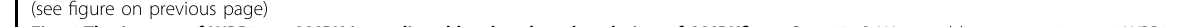
Fig. 6 The impact of WBP2 on AMPK is mediated by the phosphorylation of AMPK β 1 at Ser108. A Western blot assays using anti-WBP2 and anti-Flag to detect the expression of WBP2 and exogenous AMPK β 1 in WBP2 wild-type (WT) and WBP2 knockout (KO) LO2 cells. β -actin served as loading control. Immunoprecipitation assays using anti-Flag and western blot assays using anti-phospho-(Ser/Thr) (Phos S/T) to detect the phosphorylation of AMPK β 1. B Western blot assays using anti-WBP2 and anti-Flag to detect the expression of WBP2 and exogenous AMPK β 1 (including wild-type (WT) or Ser108 mutated to Ala108 (S108A) plasmids) in the WBP2 knockout (KO) LO2 cells. β -actin served as the loading control. Immunoprecipitation assays using anti-Flag and western blot assays using anti-phospho-(Ser/Thr) (Phos S/T) were used to detect the phosphorylation of AMPK β 1. C Western blot assays were performed to detect the expression of AMPK α , p-AMPK α , ACC, and p-ACC in the WBP2 WT cells with or without WBP2 overexpression, with or without AMPK β 1 siRNA, and with or without AMPK β 1 WT or with the Ser108 to Ala108 mutation (S108A); anti-WBP2 was used to detect the expression of WBP2, and β -actin served as the loading control. Immunoprecipitation assays using anti-Flag and western blot assays using anti-phospho-(Ser/Thr) (Phos S/T) to detect the phosphorylation of AMPK β 1. D Relative AMPK complex activity compared with the wild-type AMPK complex was measured by the ADP-Glo TM kit according to the generation of ADP. Puri fi ed AMPK subunits and WBP2 were incubated. Part of the mixture was used to measure luminescence, and western blot assays were used to detect the phosphorylation of AMPK α and AMPK β . E Representative photomicrographs with Nile red staining are shown for the WBP2 WT cells with or without WBP2 overexpression, with or without AMPK β 1 siRNA, and with or without AMPK β 1 WT or S108A exposed to PA (0.25 mM) for 12 h. The Nile red- stained area was quanti fi ed by ImageJ software. Scale bar, 100 μ m. Data are expressed as the mean ± SEM, *** P < 0.001 between the two indicated